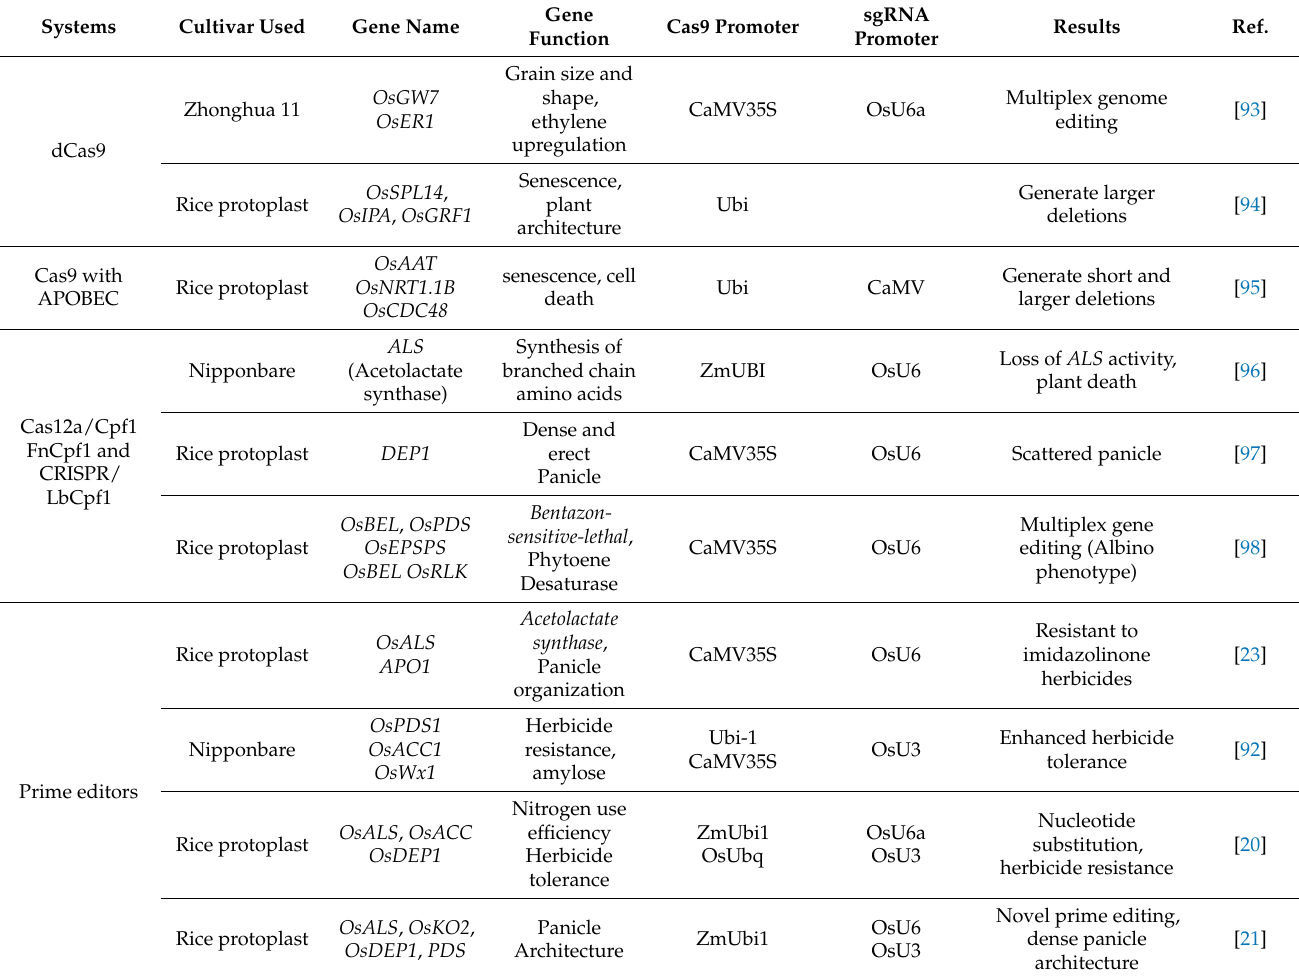
Table 5. Examples of application of prime editing and Cas proteins variants for rice crop